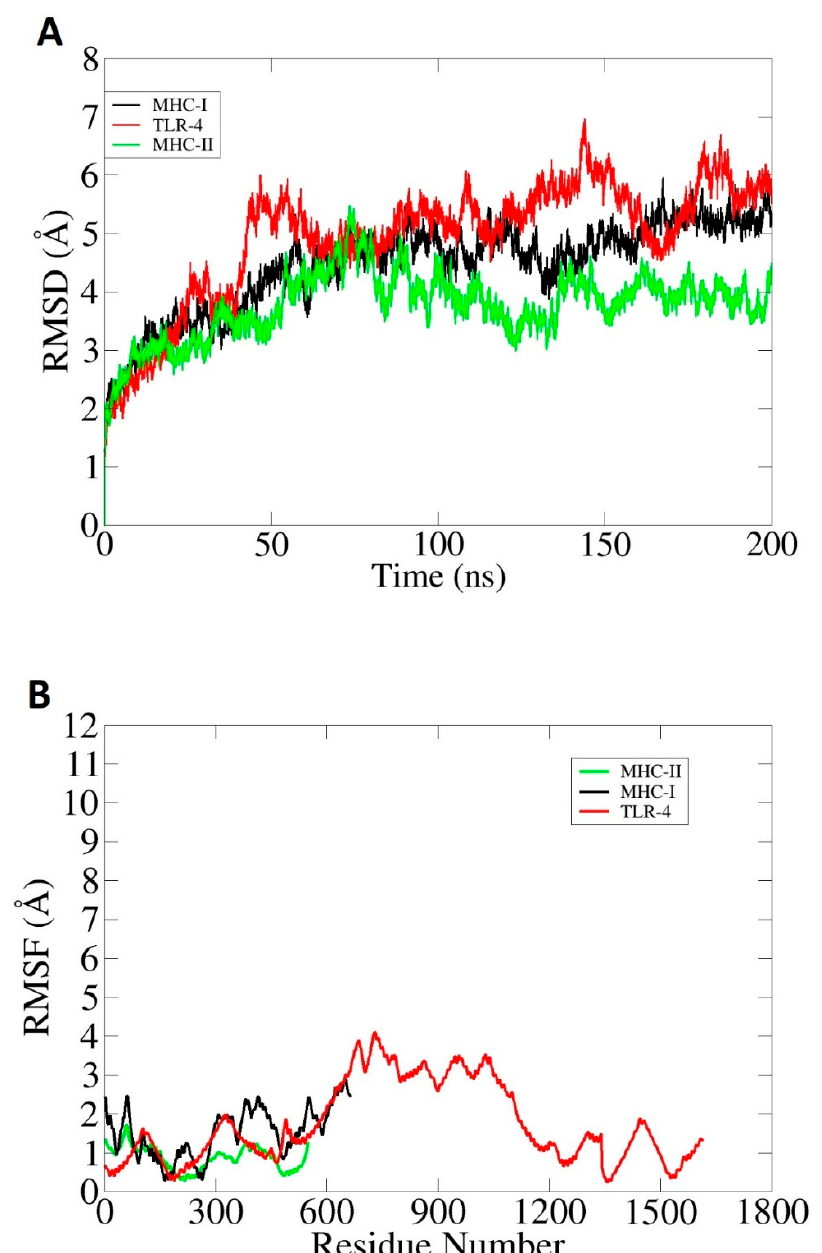
Figure 13. Graphical representation of simulation trajectories: ( A ) RMSD; ( B ) RMSF. These analyses were performed based on carbon alpha atoms. Table 4. Estimation of binding free energies in kcal/mol by MM-GBSA and MM-PBSA methods.